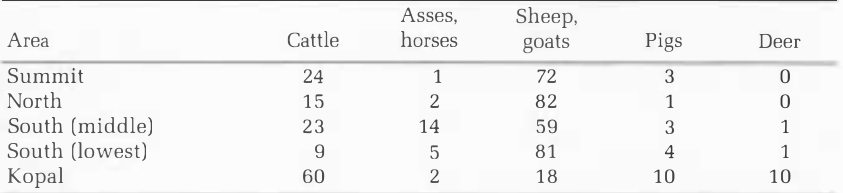
Table 1 The relative proportions(%) of the main food animals represented in the four excavation areas at (:atalhoyiik discussed in the text: Summit, North, South (middle and lowest levels), Kopal. Asses, Sheep, Area Cattle horses goats Pigs Deer Summit